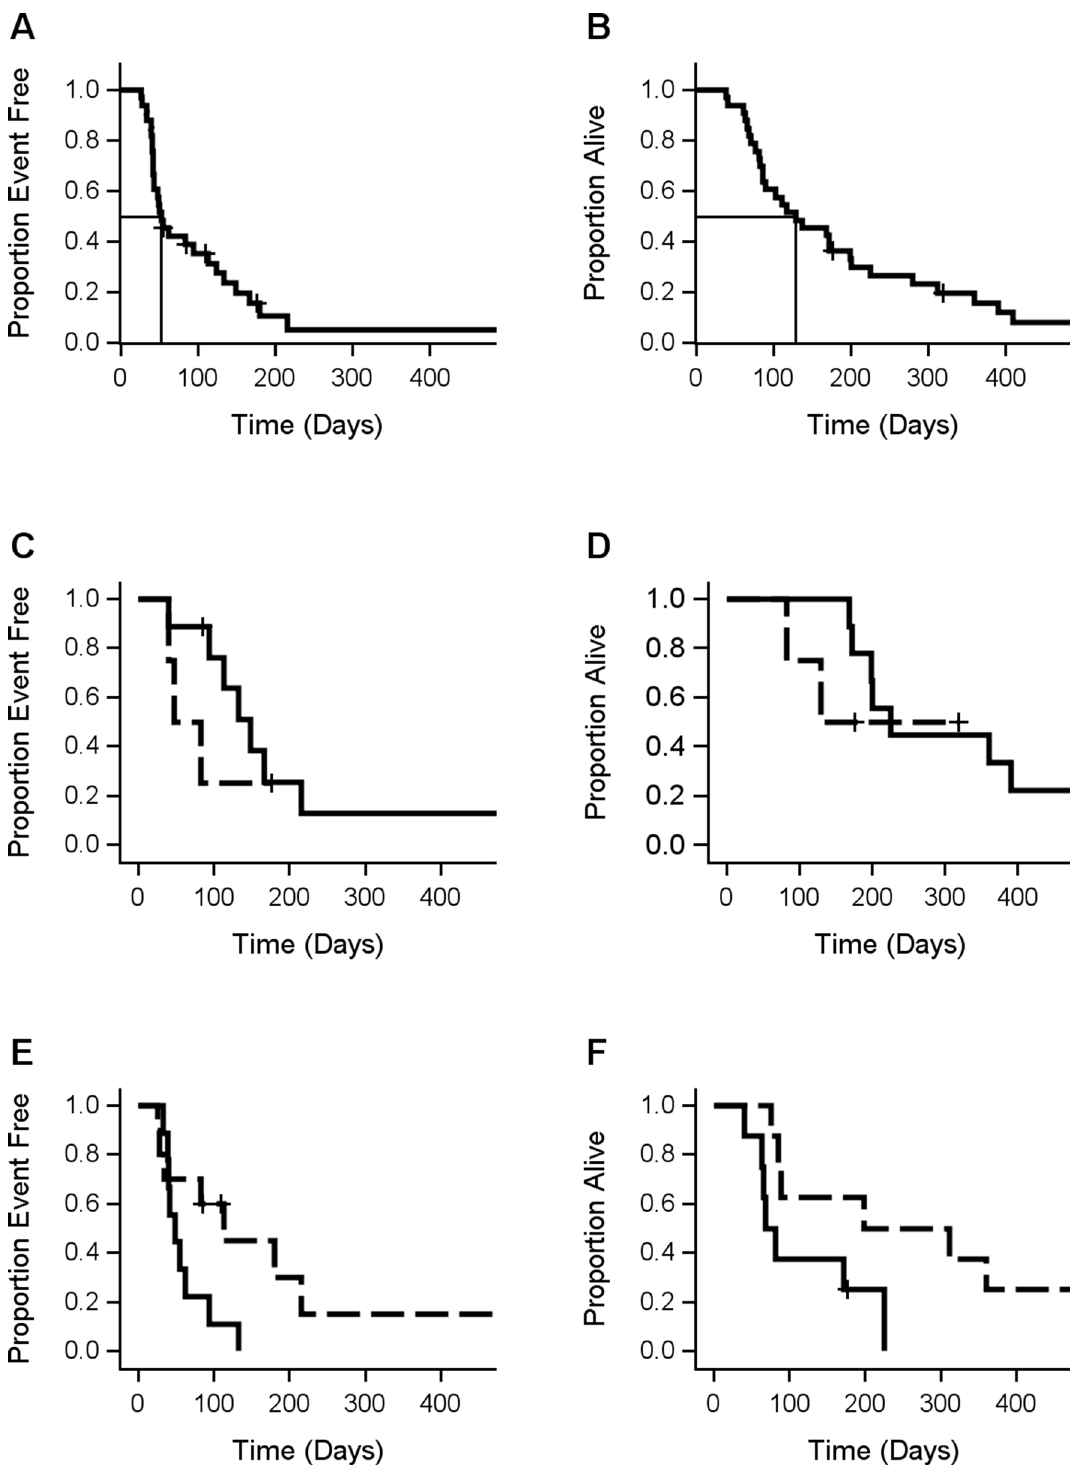
Figure 3. (A) Progression-free survival in n = 33 patients. ( B) Overall survival in n = 33 patients. ( C) Progression-free survival in n = 13 patients with repeated imaging data stratified by HV Change (= HV at follow-up minus HV at baseline) < 0 (Solid, n = 9) and HV Change ≥ 0 (Dashed, n = 4); p = 0.42, ( D) Overall survival in n = 13 patients with repeated imaging data stratified by HV Change (= HV at follow-up minus HV at baseline) < 0 (Solid, n = 9) and HV Change ≥ 0 (Dashed, n = 4); p = 0.55, ( E) Progression-Free Survival in n = 19 patients with stratified by Tmax < 4.05 and HV ≥ 28.52 (Solid, n = 9) and Tmax ≥ 4.05 and HV < 28.52 (Dashed, n = 4) (p = 0.05) based on forward selection from a multivariate model of progression-free survival in terms of all imaging parameters, ( F) Overall survival in n = 16 patients with stratified by nrCVB_et ≥ 1.5 and Tmax < 4.05 (Solid, n = 8) and nrCBV_et < 1.5 and Tmax ≥ 4.05 (Dashed, n = 8) (p = 0.04) based on forward selection from a multivariate model of overall survival in terms of all imaging